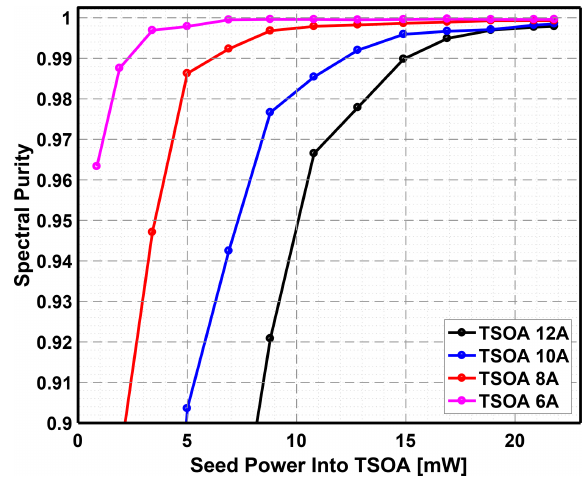
Figure 9. Accuracy in absorption cross-section estimate for water vapor (black) and O 2 (red) – which is used to measure temperature – for a 10A TSOA pulse at 8kHz for a duration of